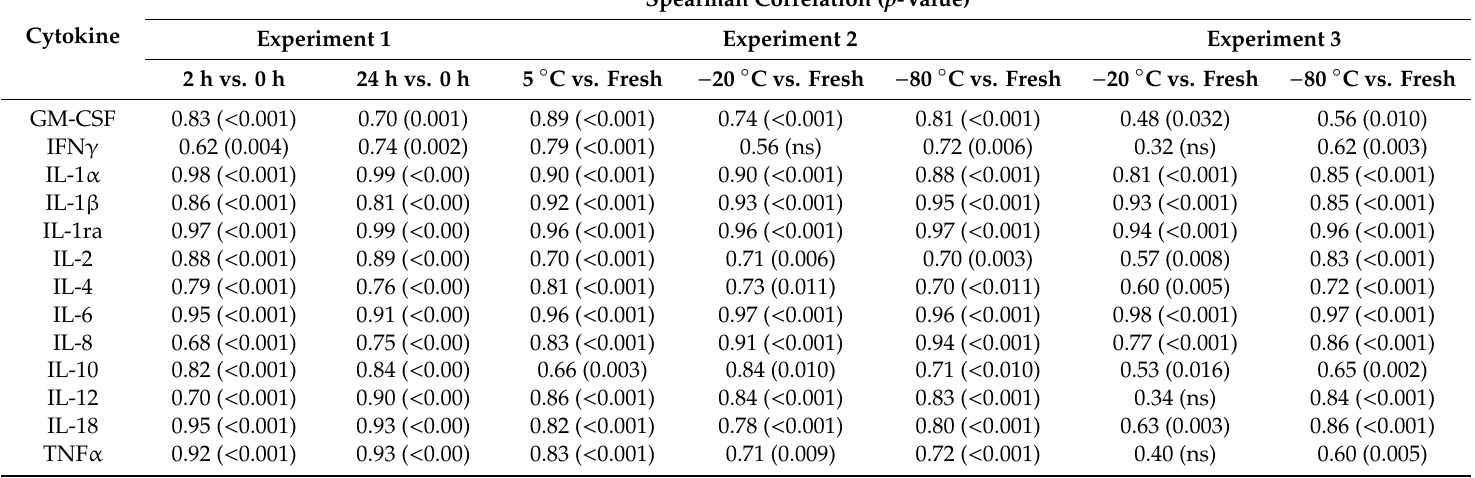
Table 2. Spearman’s correlation coe ffi cients (significance in brackets) showing linearity between the cytokine concentrations measured in baseline seminal plasma (SP) samples and those measured in experimental SP samples for each experiment. Cytokines: Granulocyte macrophage colony-stimulating factor (GM-CSF), interferon-gamma (IFN γ ), interleukin (IL)-1 α , IL-1 β , IL-1ra, IL-2, IL-4, IL-6, IL-8, IL-10, IL-12, IL-18 and tumor necrosis factor- α (TNF α ). Experiment 1: SP samples harvested immediately (0 h), 2 h and 24 h after ejaculation; Experiment 2: Fresh and stored SP samples for 72 h at 5 ◦ C, − 20 ◦ C and − 80 ◦ C; Experiment 3: Fresh and stored SP samples for two months at − 20 ◦ C and − 80 ◦